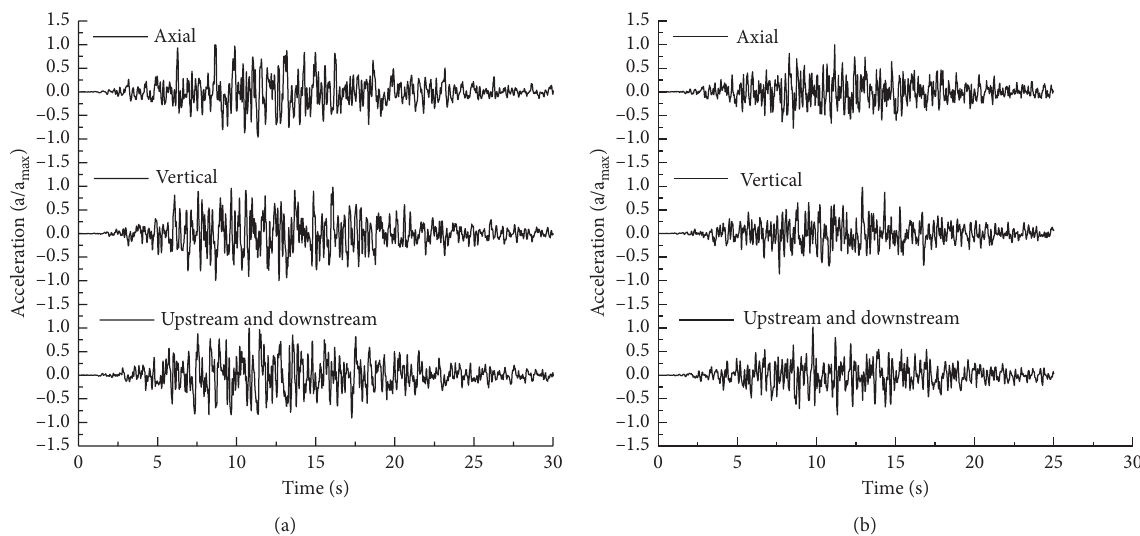
Figure 3: Time-history accelerations of the response spectrum. (a) Time-history accelerations of the site-related response spectrum based on scenario earthquake (SRRS). (b) Time-history accelerations based on